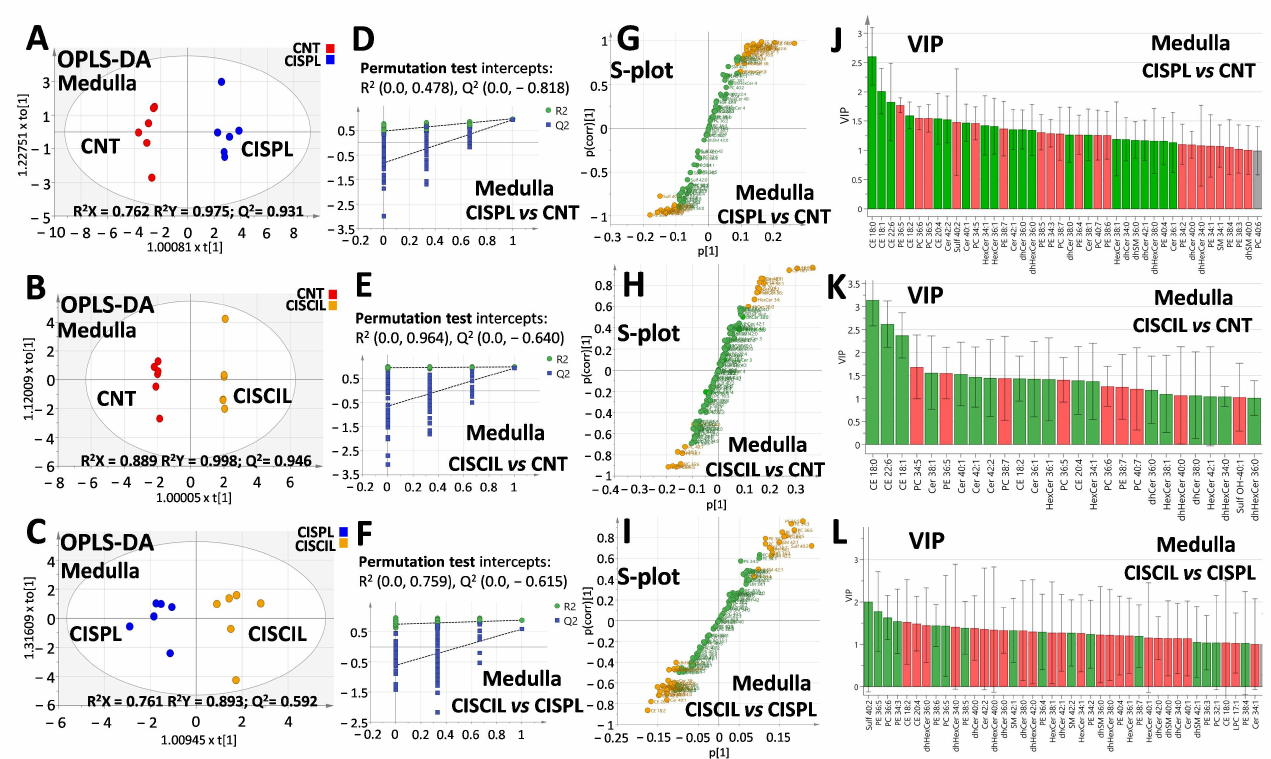
Figure 10. OPLS-DA analysis for renal medulla lipids. Score plots for ( A ) CISPL vs. CNT, ( B ) CISCIL vs. CNT, and ( C ) CISCIL vs. CISPL. Permutation tests based on 100 iterations for the models for ( D ) CISPL vs. CNT, ( E ) CISCIL vs. CNT, and ( F ) CISCIL vs. CISPL. S-plots are presented with those features with both |p(corr)| > 0.5 and VIP > 1 marked in orange for ( G ) CISPL vs. CNT, ( H ) CISCIL vs. CNT, and ( I ) CISCIL vs. CISPL. VIP plots are presented in green and red for features with a value >1, with an increasing and decreasing trend, respectively; for ( J ) CISPL vs. CNT, ( K ) CISCIL vs. CNT, and ( L ) CISCIL vs.